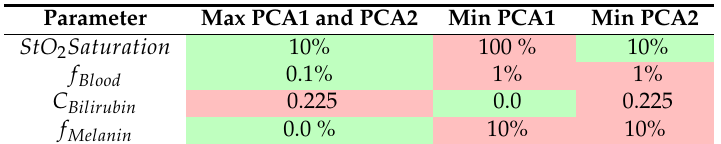
Table 4. Monte Carlo Simulation parameters for the extreme points according to the principle components. Red background items indicate the maximum of their particular parameter, while green background indicate minima for the range of input